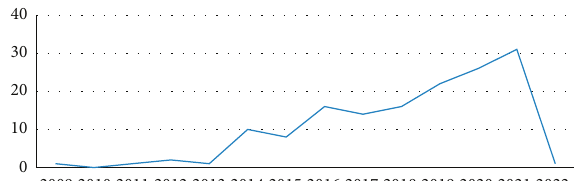
Figure 28: Article distribution by disciplines for mixed studies review